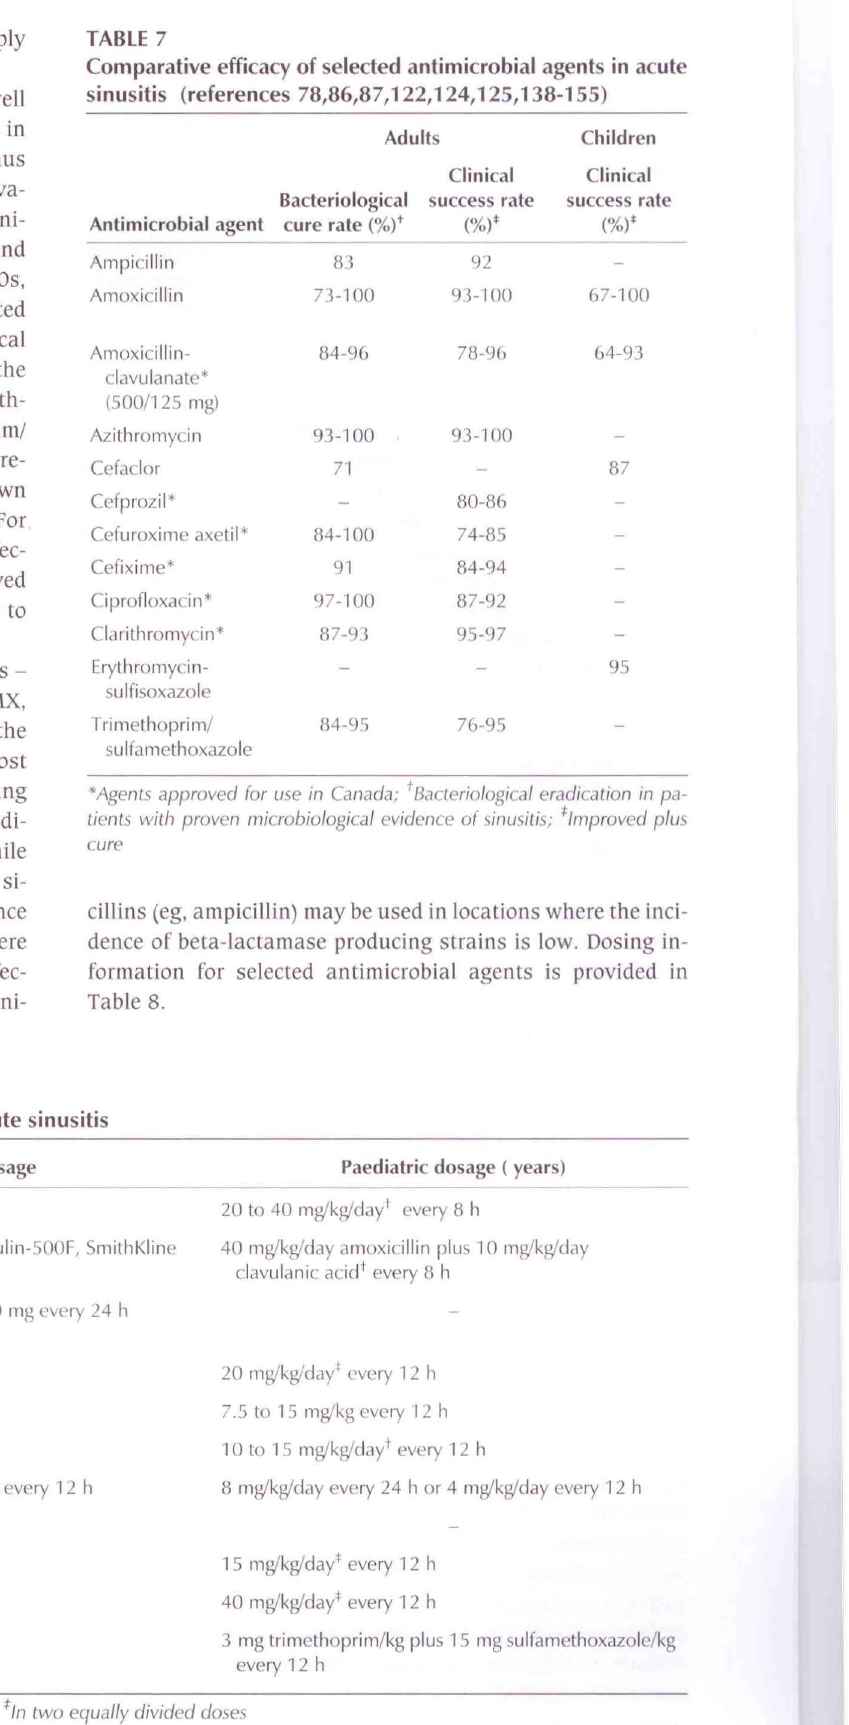
Comparative efficacy of selected antimicrobial agents in acute sinusitis (references 78,86,87, 122,124,125, 138-155)